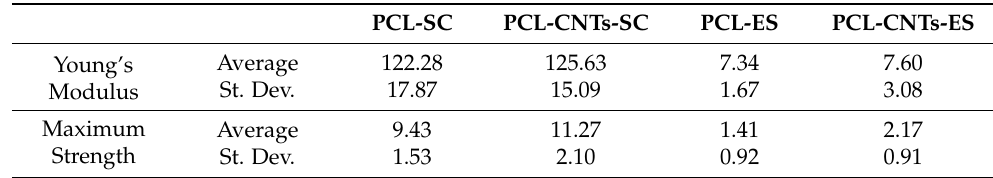
Table 5. Mechanical properties of substrates (MPa).